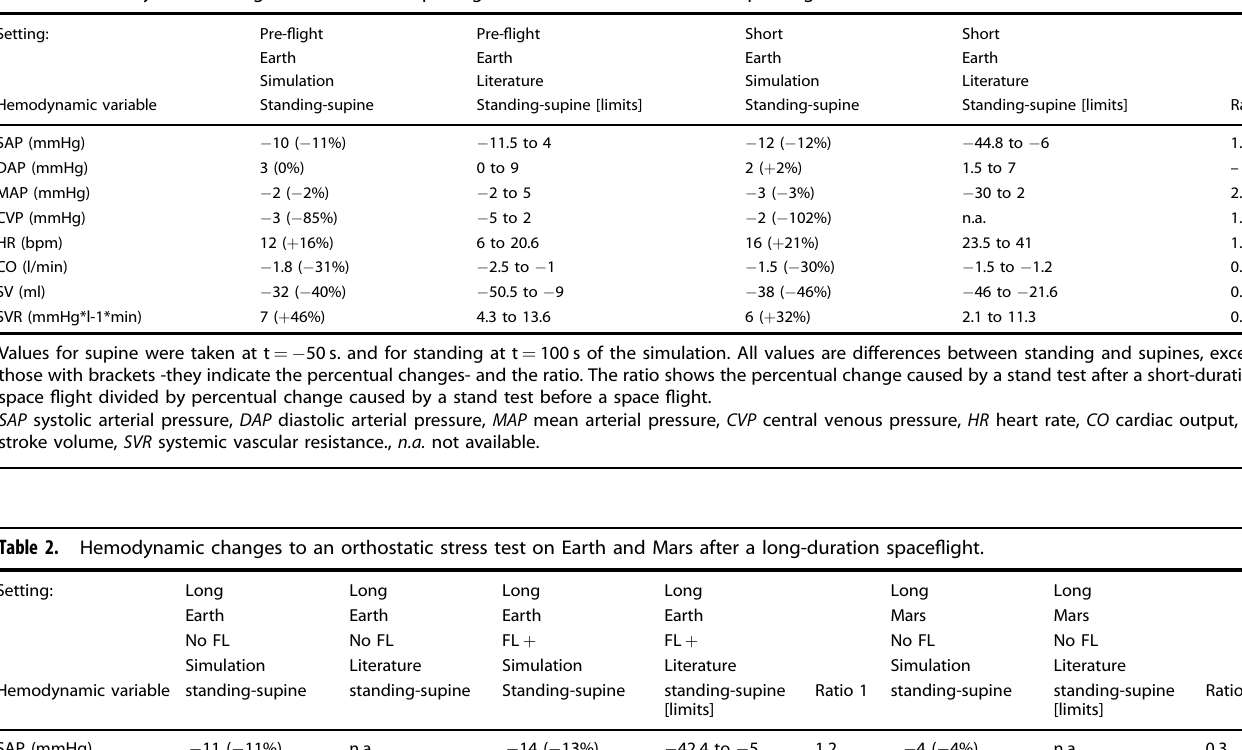
Table 1. Hemodynamic changes to a stand test pre- fl ight and after a short-duration space fl ight. Setting: